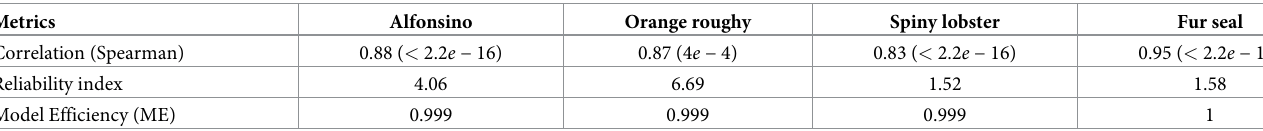
Table 4. Metrics used to determine the skill in model assessment. p-values are provided in